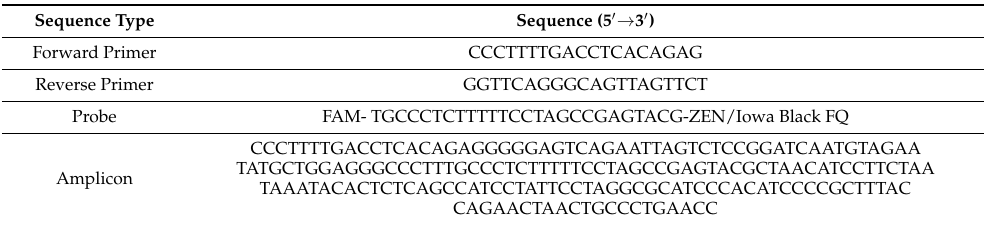
Table 1. Nucleotide sequences for the qPCR-based eONKI4 eDNA tool comprised of primers and a probe for coho salmon. The amplicon sequence for the creation of the synthetic DNA sequence is included. FAM, reporter dye; ZEN/Iowa Black FQ, quencher.